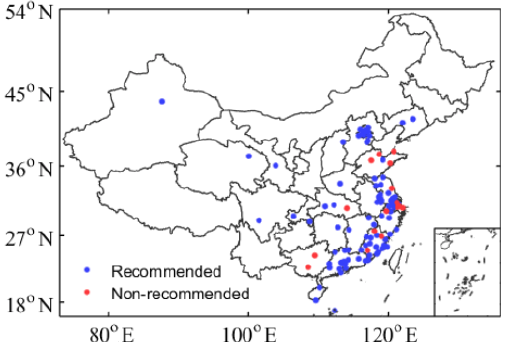
Figure 8. Recommended and non-recommended sites of the radar wind profiler network of China. The blue dots represent the 89 rec- ommended sites and red dots the 17 non-recommended